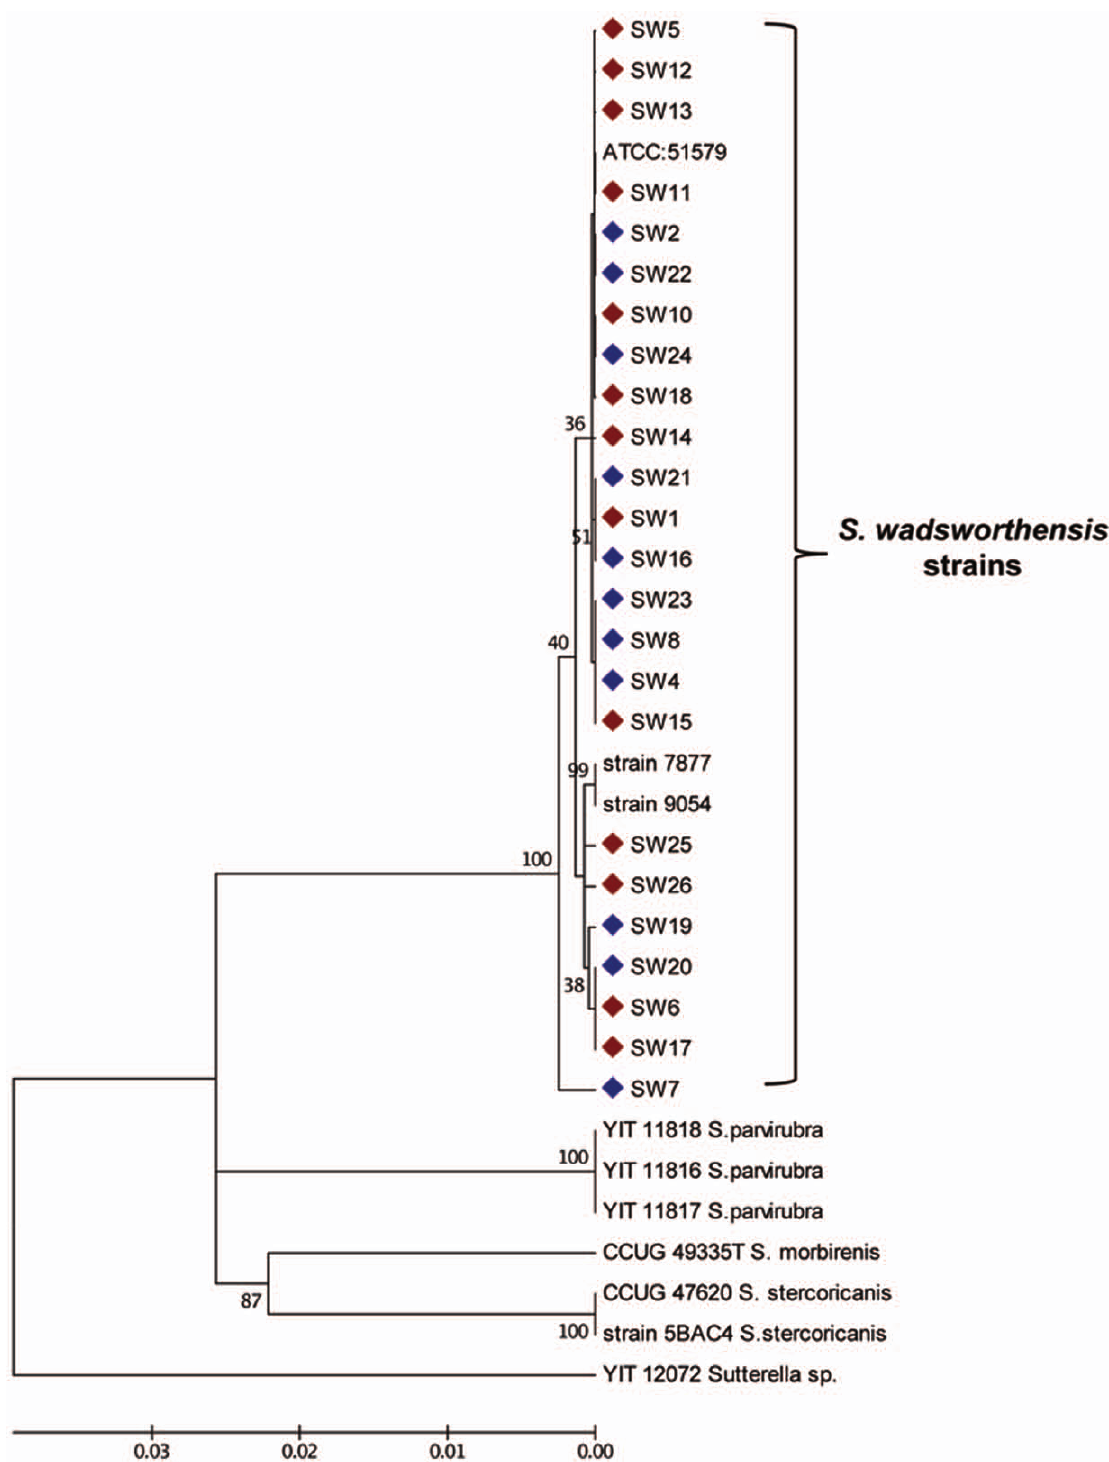
Figure 3. Phylogenetic tree constructed using nearly full-length ( , 1400 bp) sequences of the 16S rRNA gene of S.wadsworthensis strains from UC and controls alongside other Sutterella sequences available in GenBank. The evolutionary history was inferred using the Neighbor-Joining method. The percentage of replicate trees in which the associated taxa clustered together in the bootstrap test (1000 replicates) are shown next to the branches. The tree is drawn to scale, with branch lengths in the same units as those of the evolutionary distances used to infer the phylogenetic tree. The S. wadsworthenis isolates from IBD cases are marked in red and those from controls are marked in blue.